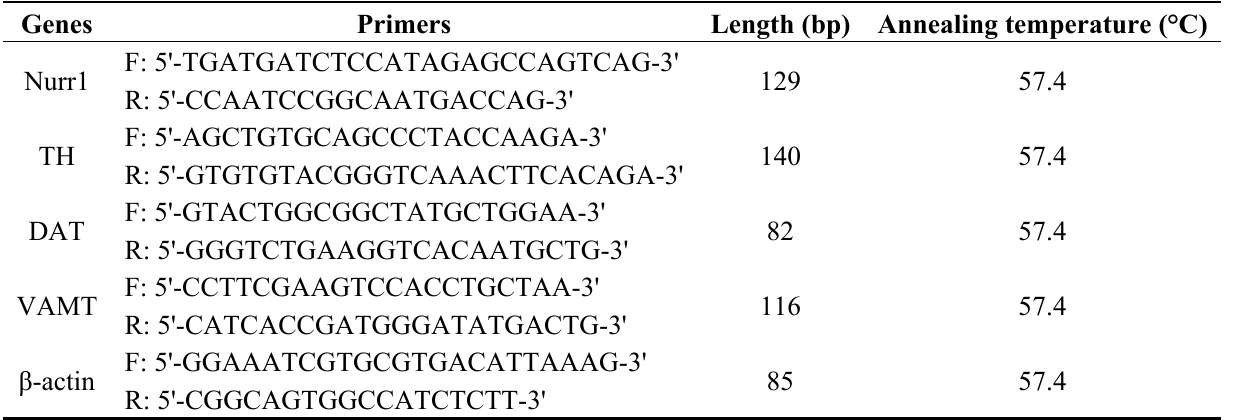
Table 1. Primer nucleotide sequences used for real-time